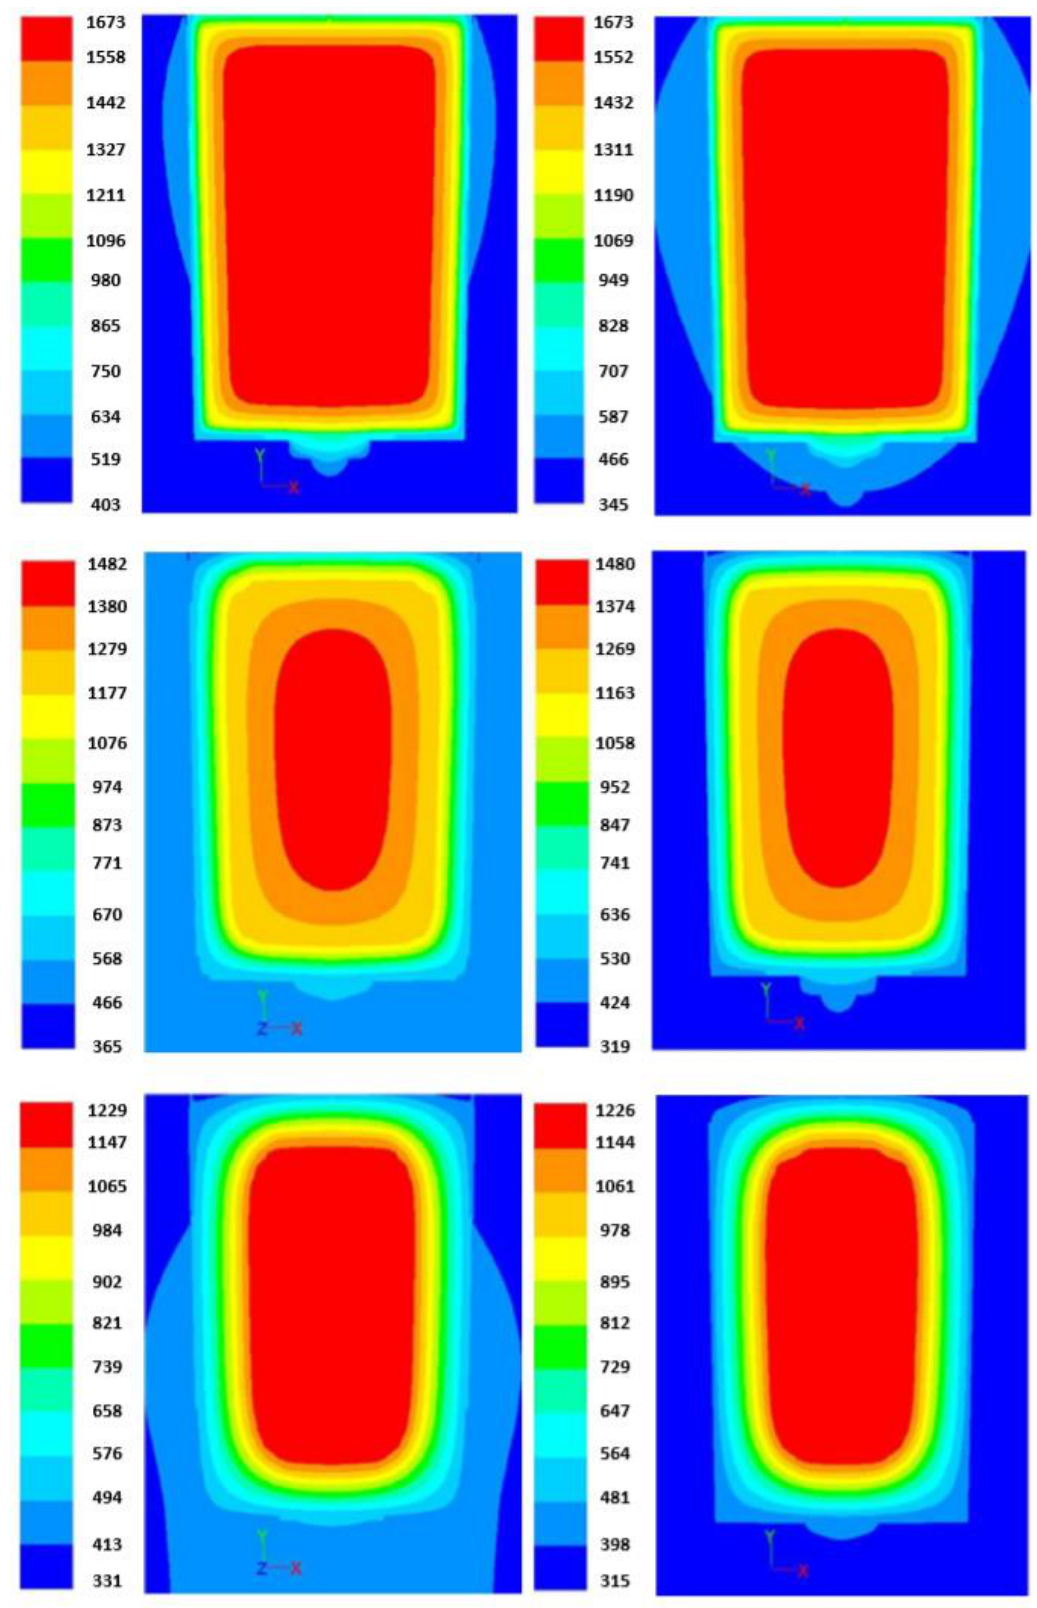
Figure 8. Temperature distribution at transversal plane (drum 1, glass properties). ( Top ) t = 1 h. ( Middle ) t = 10 h. ( Bottom ) t = 24 h. Left : 1 m/s. Right : 3 m/s.